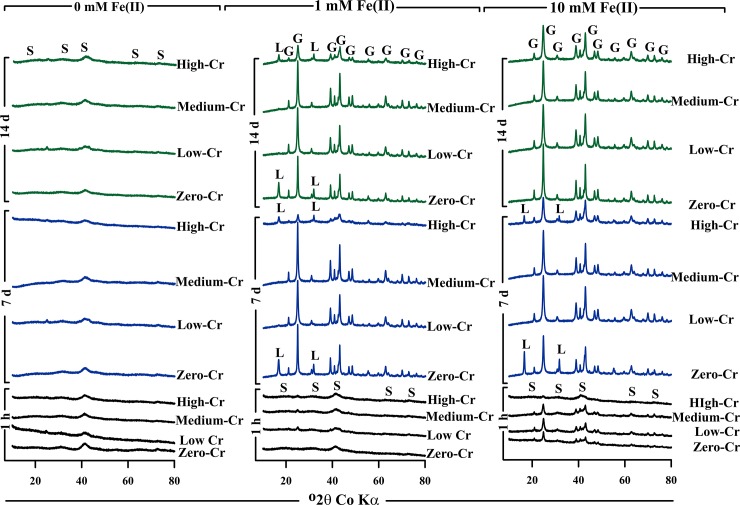
XRD patterns of material collected after allowing the zero-, low-, medium- and high-Cr(III) schwertmannite to react with 0, 1 or 10 mM Fe(II) over 1 h, 7 d and 14 d.Peaks for schwertmannite, goethite and lepidocrocite are denoted as S, G and L, respectively.